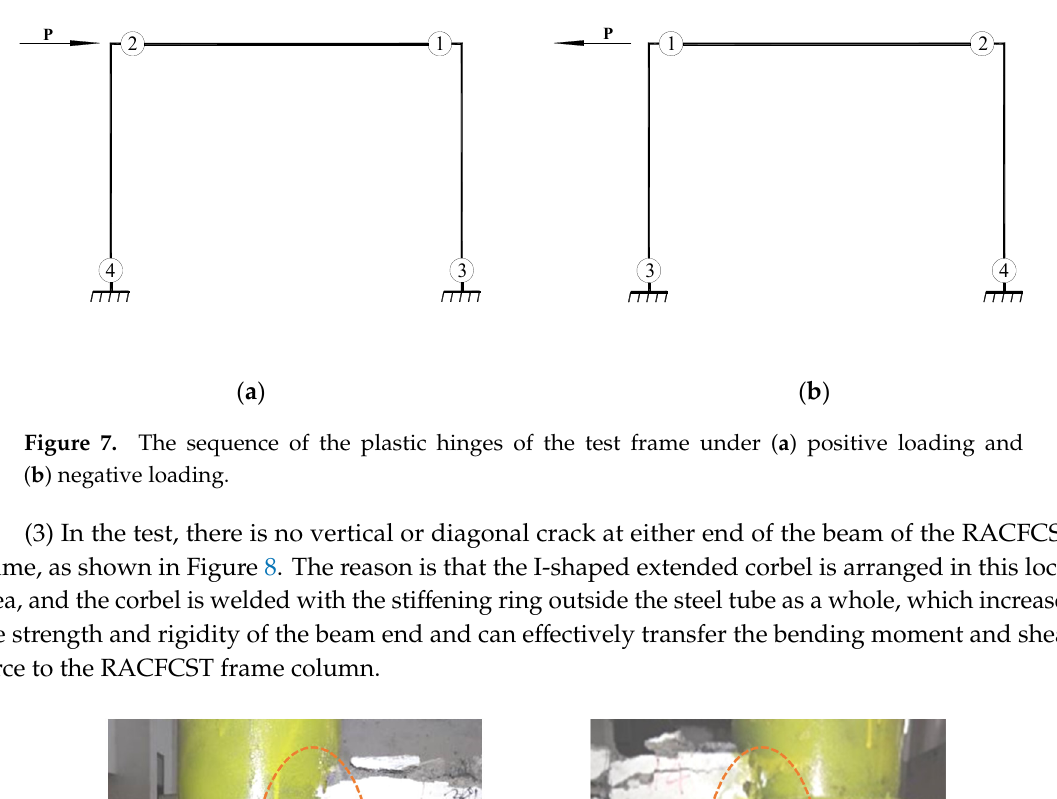
Figure 8. The core area of the joint.